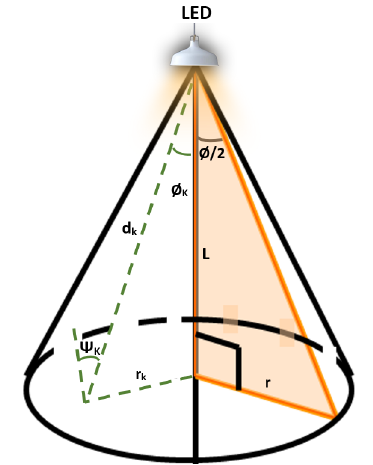
Figure 2. The line-of-sight channel of the VLC.